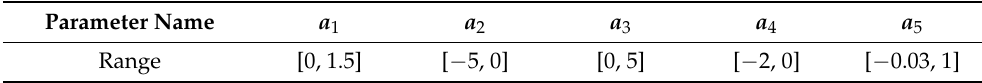
Table 3. The range of each factor in the AoA distribution